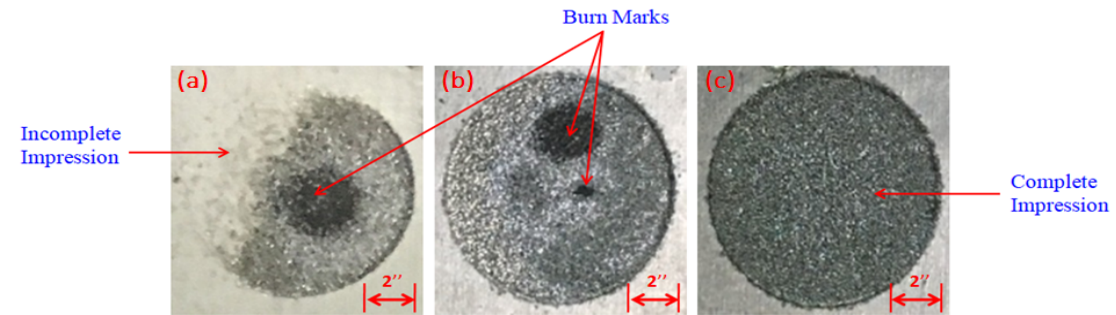
Figure 3. Undesired scenarios of preliminary trial experiments: ( a ) incomplete impression with burn mark; ( b ) burn Marks; ( c ) complete impression.